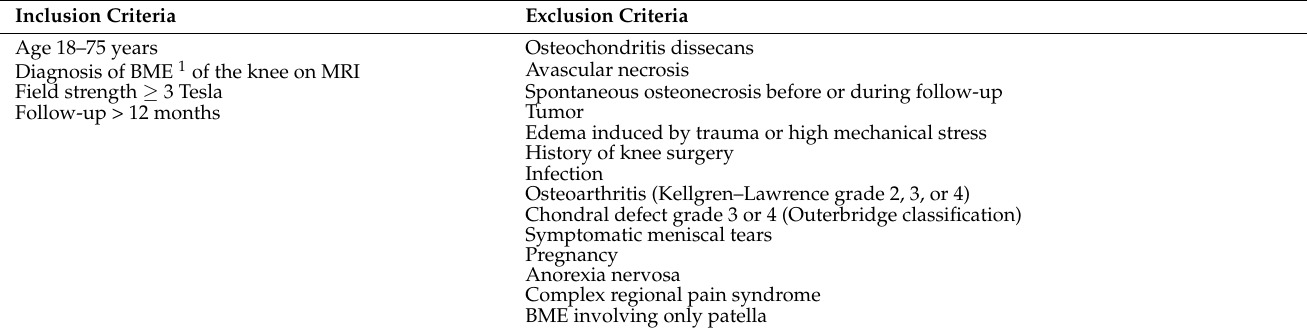
Table 1. Inclusion and exclusion